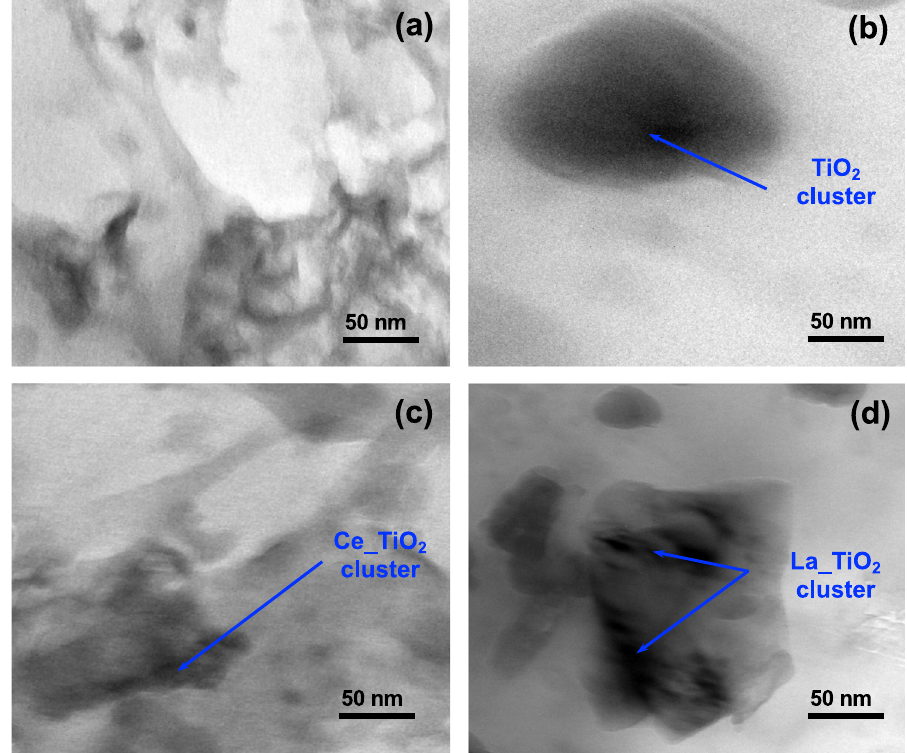
Fig. 3 TEM micrographs. a Pure_polyurea, with b un_TiO 2 , c 3%Ce-doped TiO 2 , and d 3%La-doped TiO 2 polyurea coatings. Ce/La-doped nano-TiO 2 polyurea coating was observed with a tetragonal crystal shape.